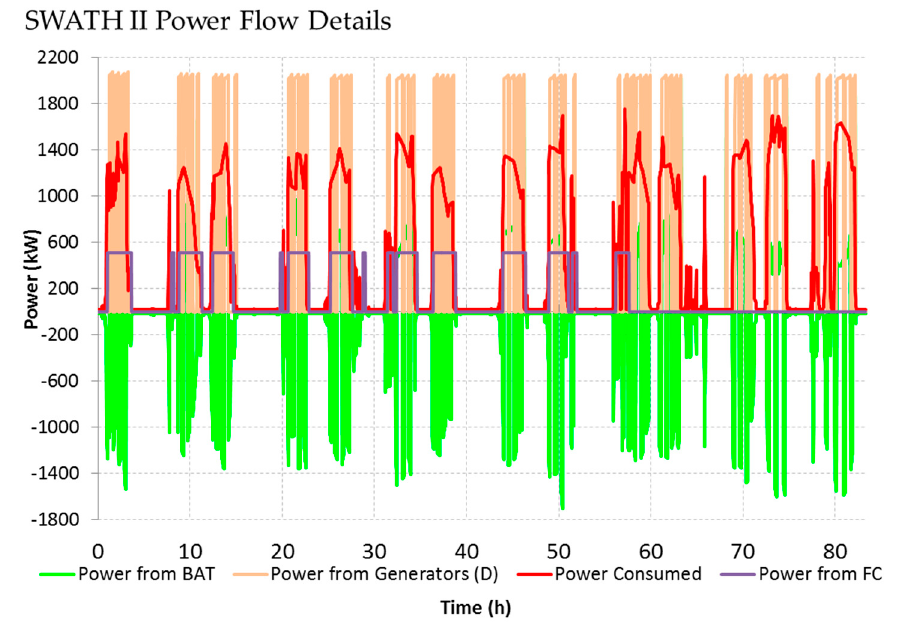
Figure 26. Plot of power flow between battery (BAT), generators (D), fuel cell (FC) and propulsion